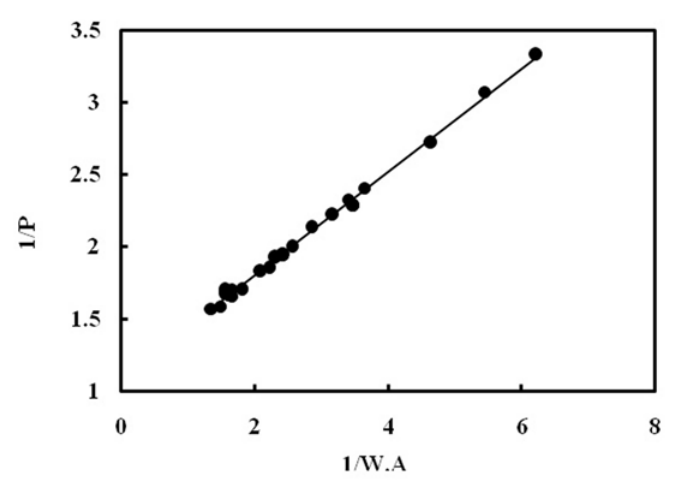
Figure 9. Relation between reciprocals of Porosity and W.A for Bagasse based